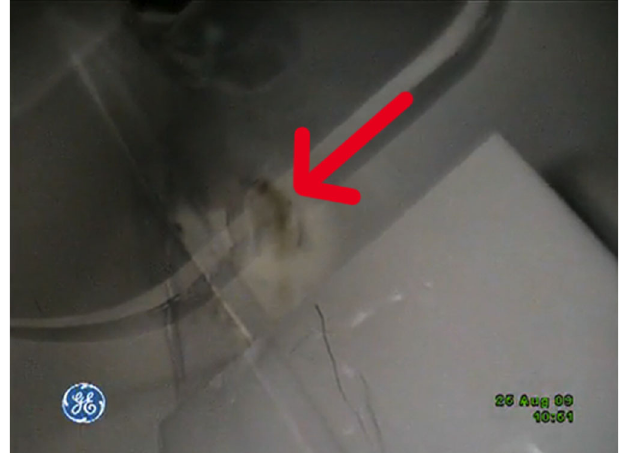
FIG. 6. A photograph of the upper inside surface of the vac- uum chamber above the stripper foil. The black ring, indicated by the arrow, is likely due to graphitization caused by reflected convoy electrons.